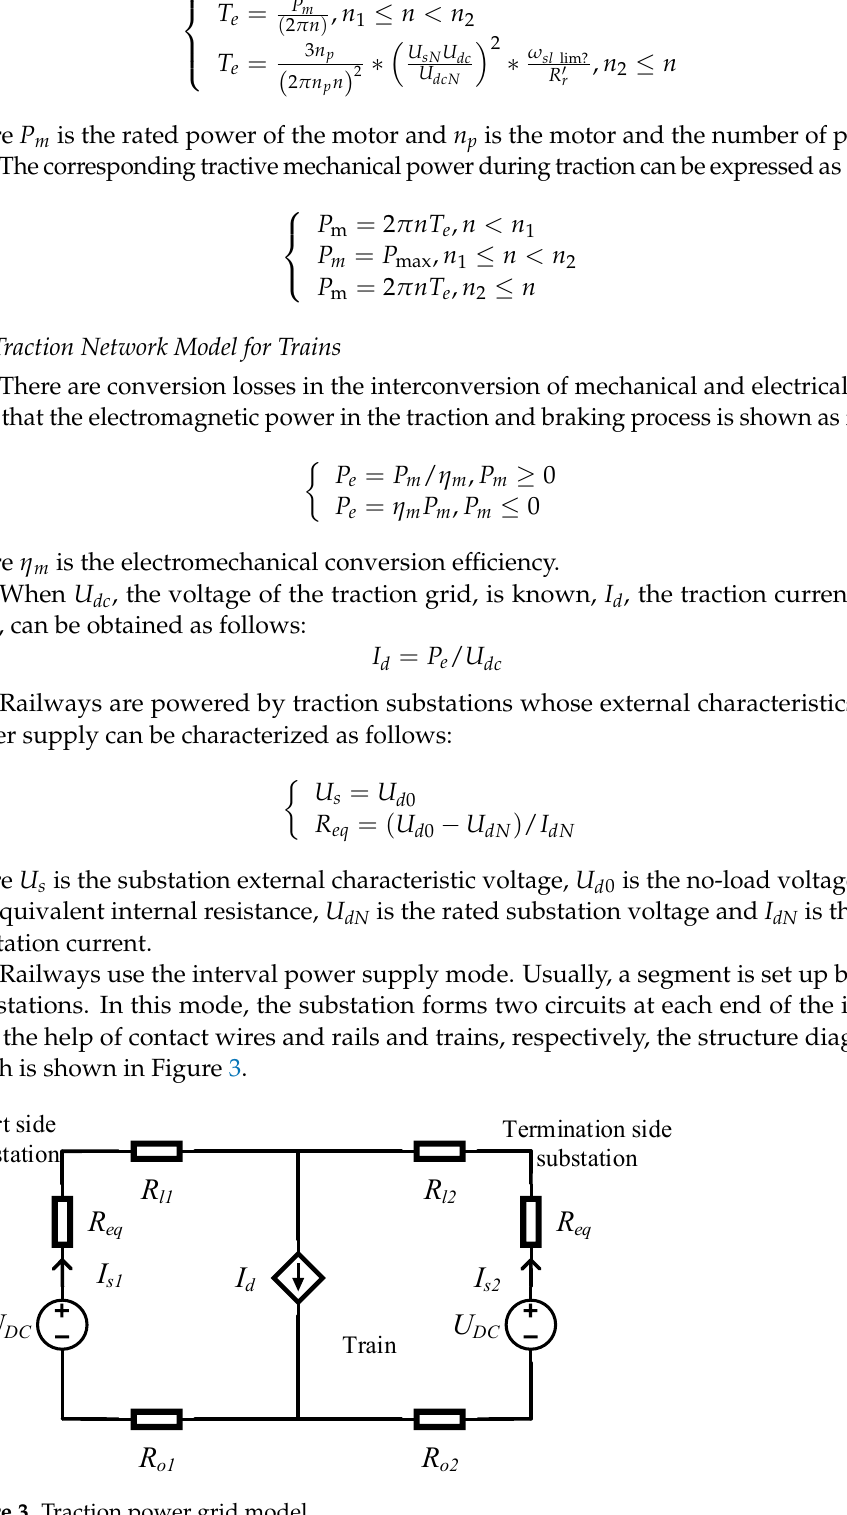
Figure 3. Traction power grid